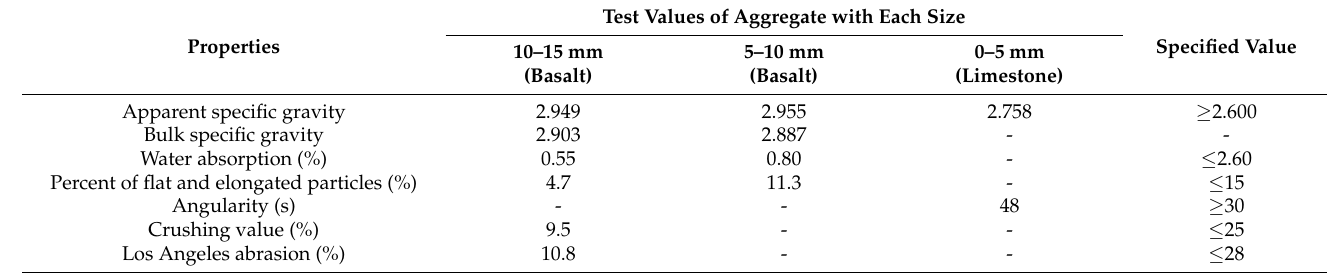
Table 3. Properties of aggregates used in this study.